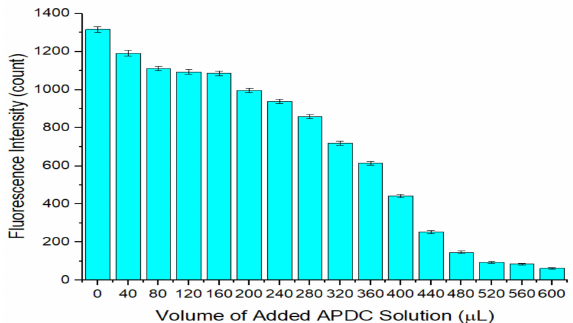
Figure 3. Relationship between the fluorescence intensity of the QD solution and the volume of added ammonium pyrrolidine dithiocarbamate (APDC) solution. Concentration of Tris-HCl bu ff er solution: 10 mmol / L. pH of Tris-HCl bu ff er solution: 8.5. Concentration of added QD solution: 5 µ mol / L. Concentration of added APDC solution: 100 µ mol / L. Addition order: Tris-HCl bu ff er solution (2 mL) → QD solution (0.4 mL) → APDC solution (0–0.6 mL) → Tris-HCl bu ff er solution (1.6–1 mL). Excitation wavelength: 460 nm. Observation time: 3 min. All data in this figure is mean of five measurements.